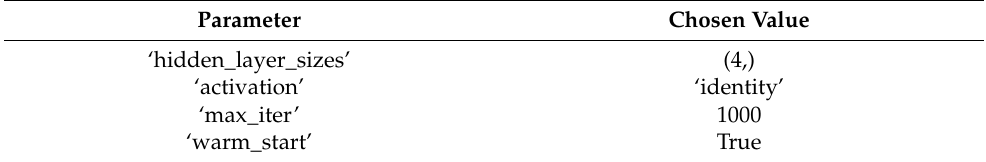
Table 1. Tuning the parameters for the MLP